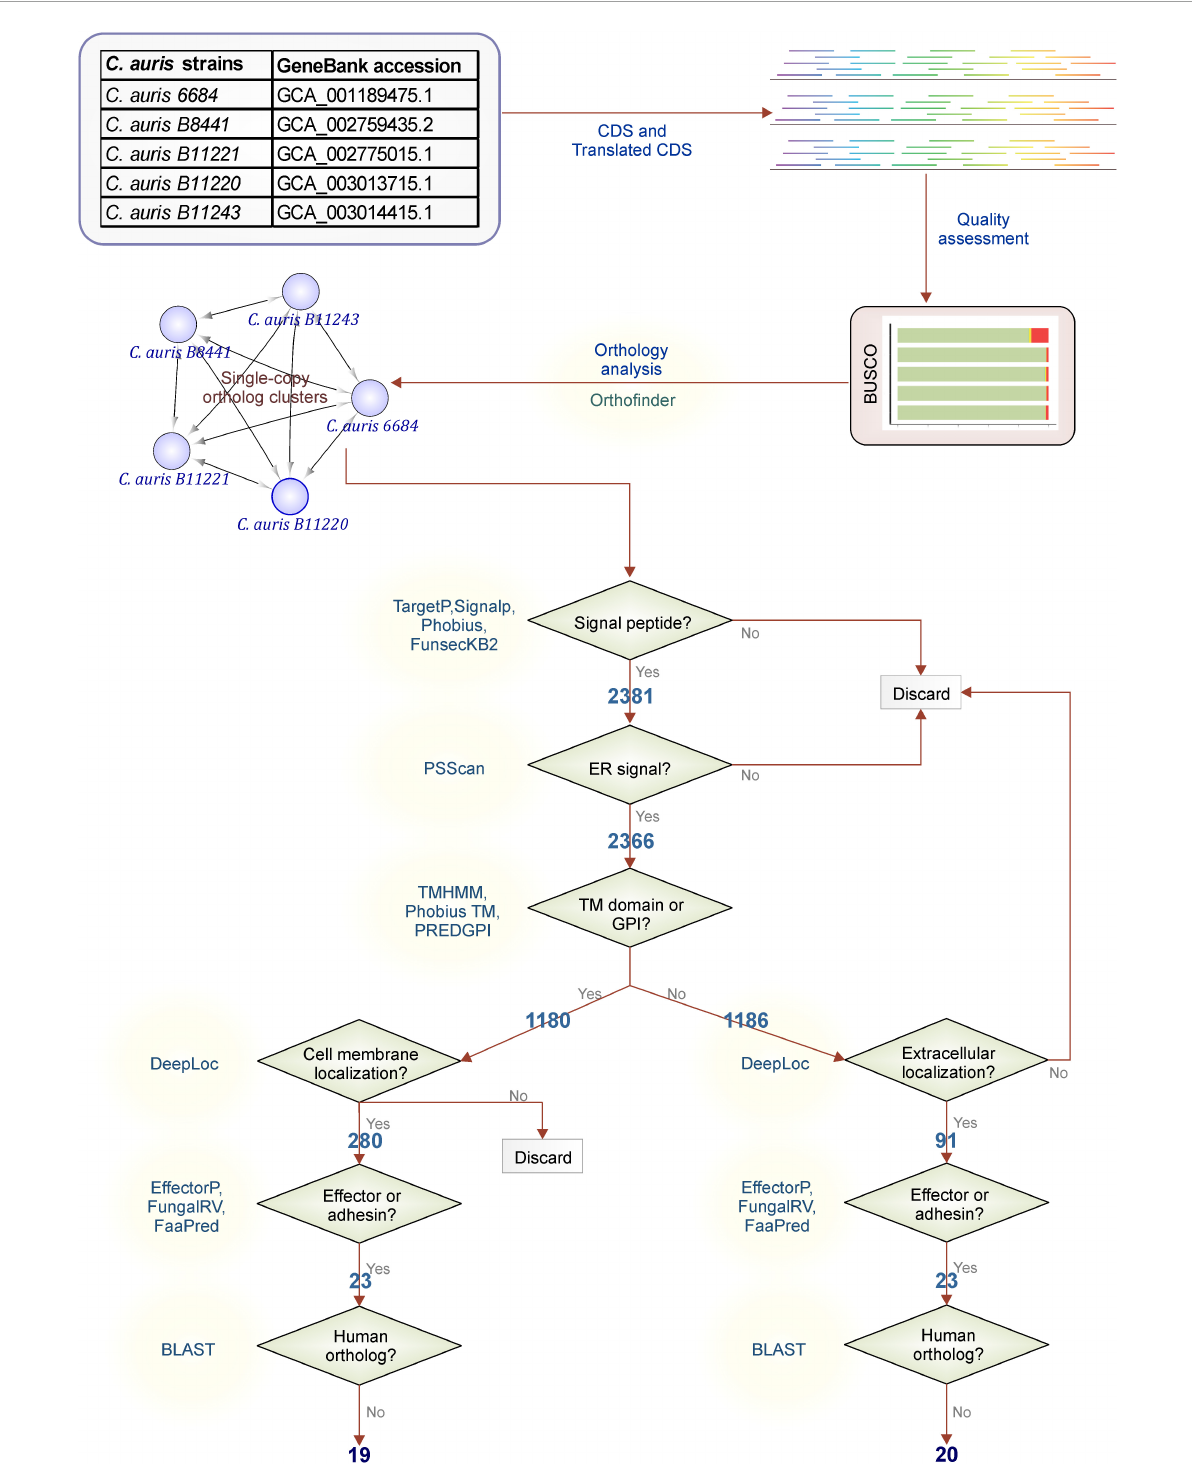
FIGURE2 Filtering workflow. Steps used for C. auris protein filtering adapted from Vivek-Ananth et al. (79) The C. auris proteins with orthologs in all strains were filtered to obtain membrane proteins or extracellular secreted proteins. Secretion to the extracellular space or to the membrane was determined by existence of a signal peptide or glycosylphosphatidylinositol (GPI) anchor or a transmembrane (TM) domain. The proteins with a endoplasmic reticulum (ER) signal peptides were filtered out to ensure the localization of the protein to the membrane or extracellular space. Further steps were taken to predict the effector or adhesins and to filter out proteins that may invoke